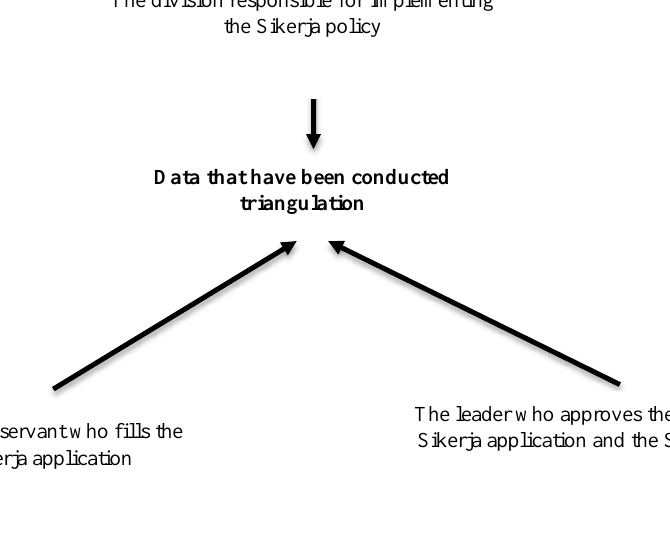
Figure 1: Data Source